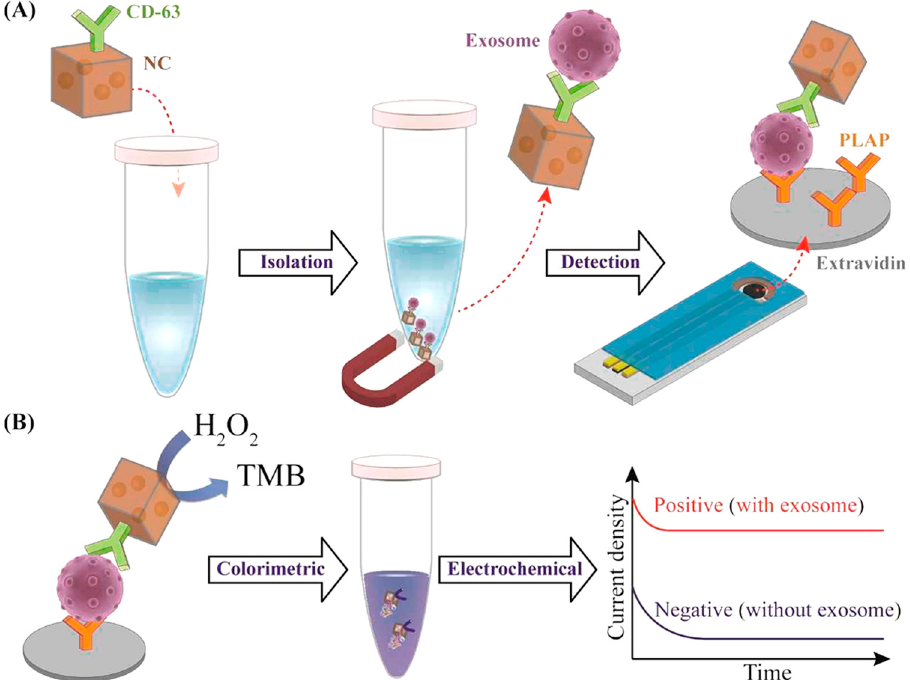
Figure 17. Scheme of the assay for direct exosome isolation and detection from cell culture media [121]. Copyright: American Chemical Society.